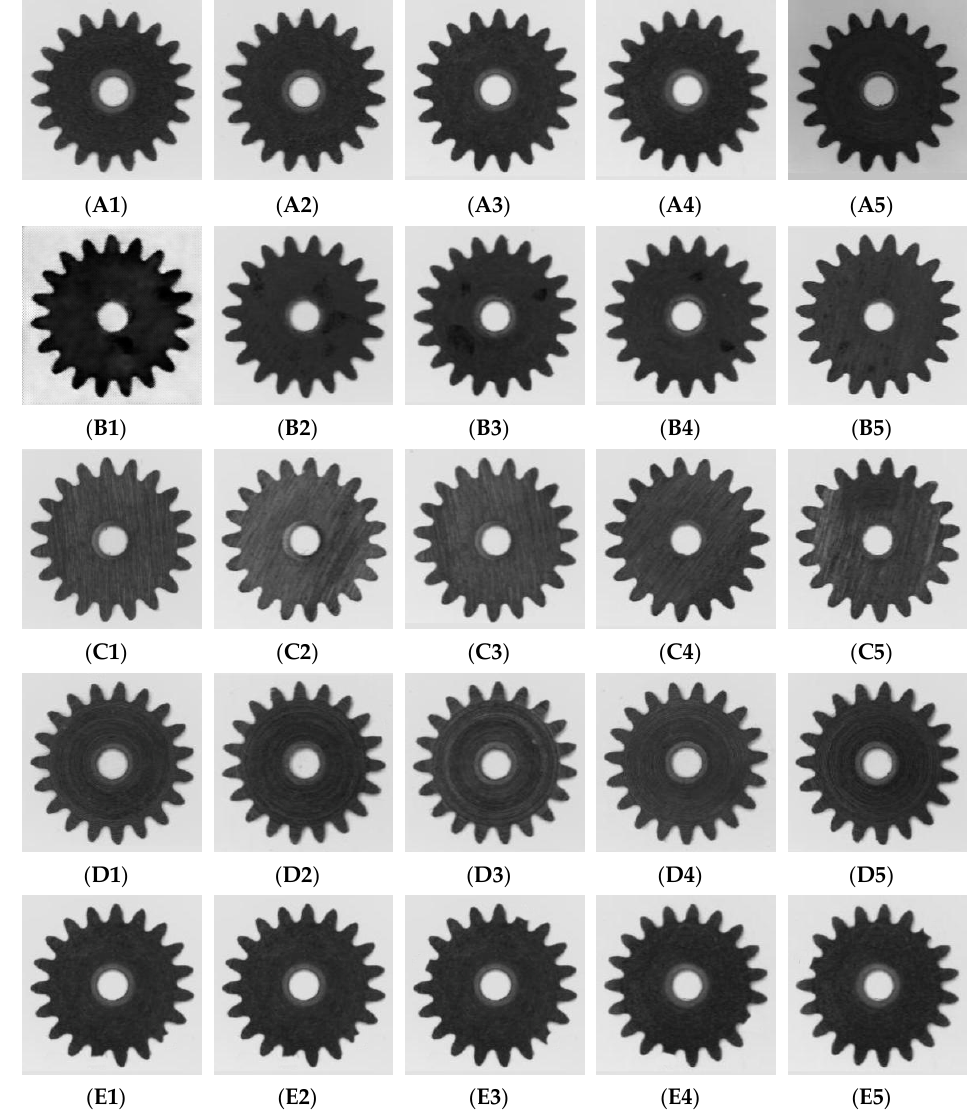
Figure 4. Example of a gear end face defect datasets: ( A1 – A5 ) Normal; ( B1 – B5 ) stain; ( C1 – C5 ) scratch; ( D1 – D5 ) circle; ( E1 – E5 )